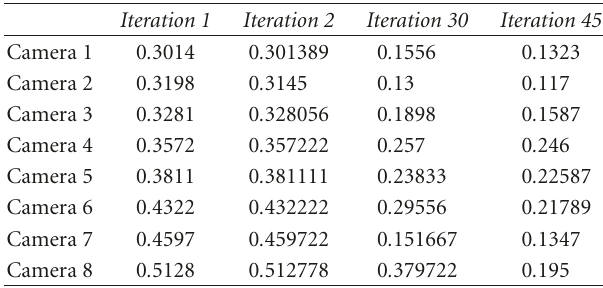
Table 7: Mis Err t i rates during incremental learning initial train- ing set = 32000. Weak and strong sensor combination used.